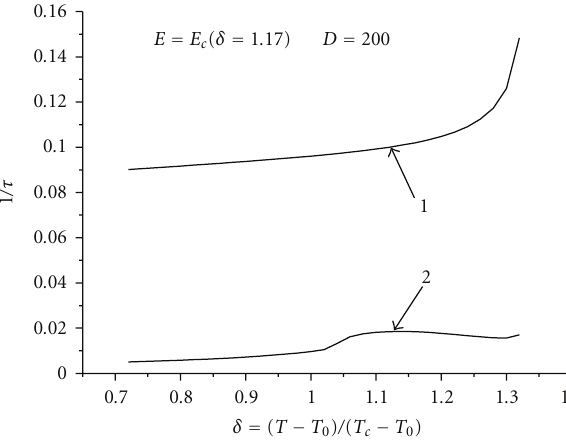
Figure 7: Dependence of the switching, 1/ τ (in units of β 2 /γη ), from the first stable ferroelectric state to the second stable ferroelectric state (or from the first metastable state to the second one) for the 2D system undergoing a first-order phase transition at E = E c ( δ = 1 . 17) on dimensionless temperature δ . The number of dipoles N = 64 × 64. The initial conditions describe the nucleus of the ferroelectric phase inside the domain with polarization of the opposite direction. The results are given for the values of D and ν corresponding to those for BaTiO 3 ( D = 200, ν = 40, curve 1) and for D = 200, ν = 0 . 4 (curve 2). The large value of the coe ffi cient of the interaction between nearest neighbours results in the smoothing out of the maximum. At small value of ν the maximum appears.